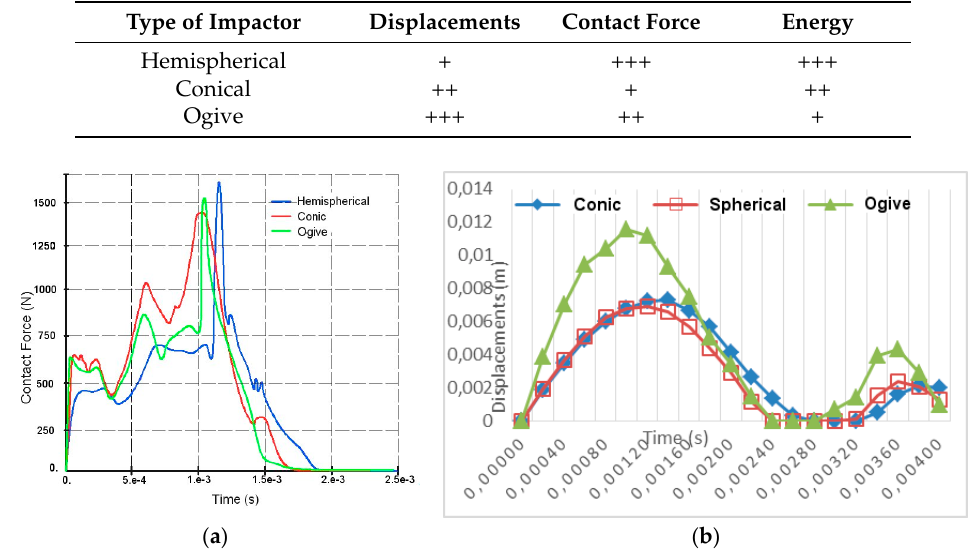
Figure 9. Time dependence of ( a ) the impactor’s contact force and ( b ) the impactor’s displacement. Table 2. Comparative effects impactors, displacement contact force and energy produced. “+”, ”++”, and “+++” used for low, moderate, and high values, respectively.